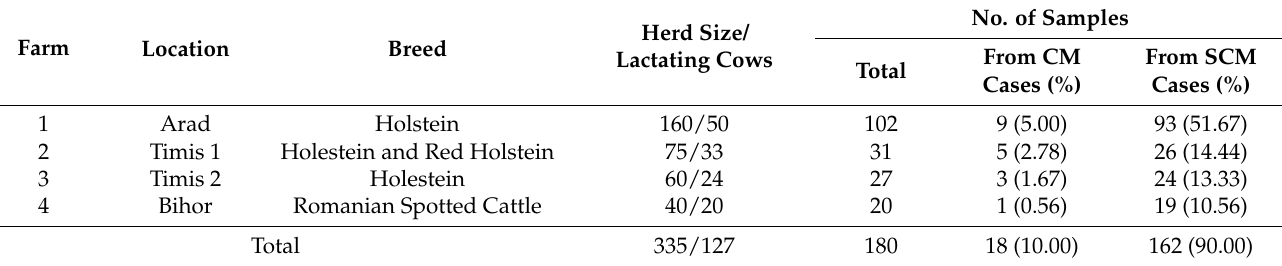
Table 6. Distribution of farms and animals sampled in the